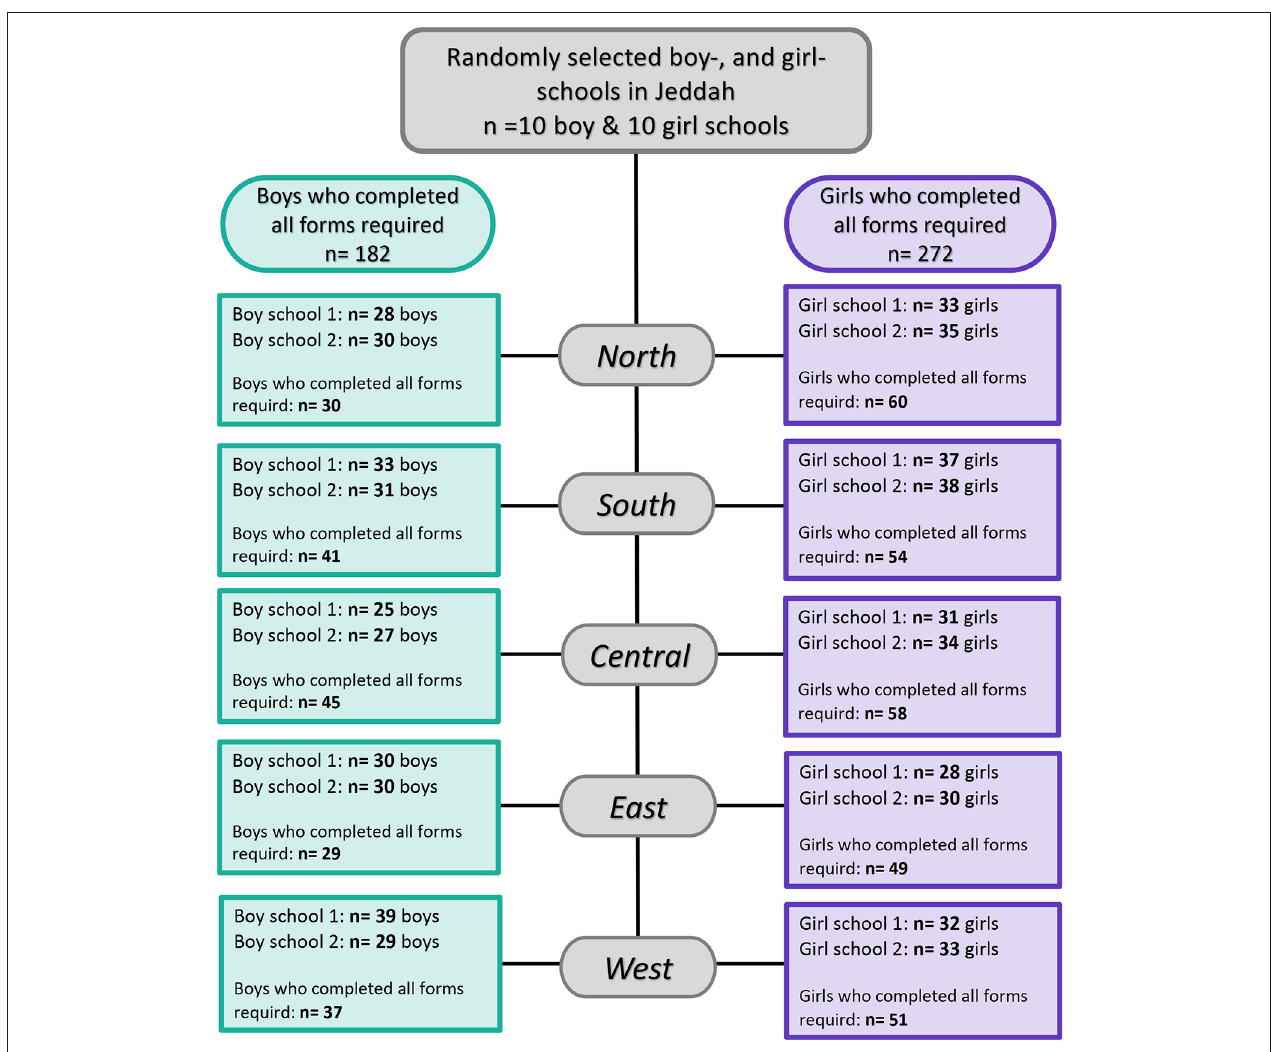
FIGURE 1 | Flowchart illustrating child and adolescent participation in this study among the general population in Jeddah, Saudi